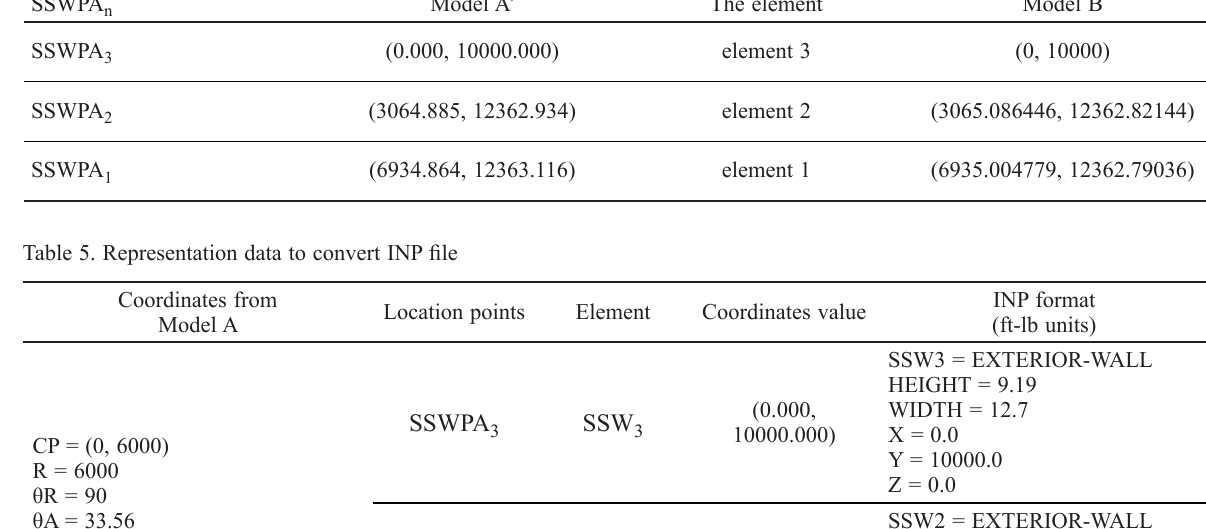
Table 4. Comparison between models A and B